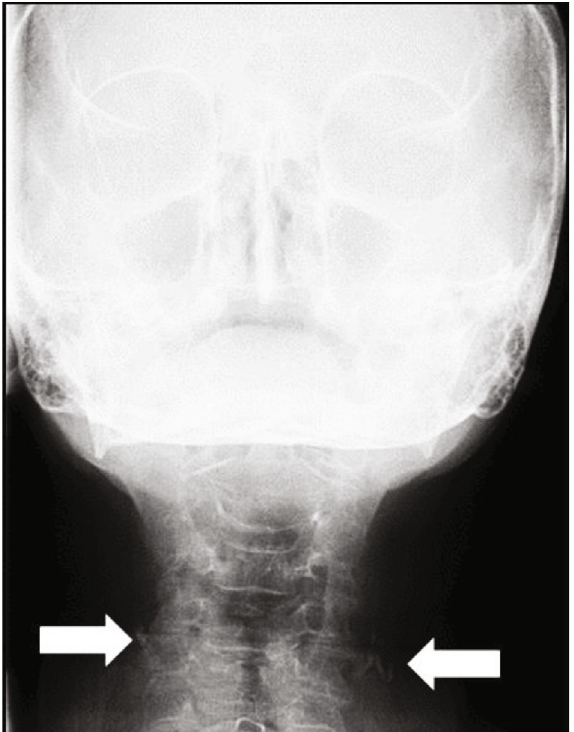
Figure 3: Manzi Projection showing radiopaque image circumscribed on both sides of the neck soft tissue region, in which the left side is adjacent to the C3 and C4 intervertebral space (arrow) and the right side is adjacent to the C4